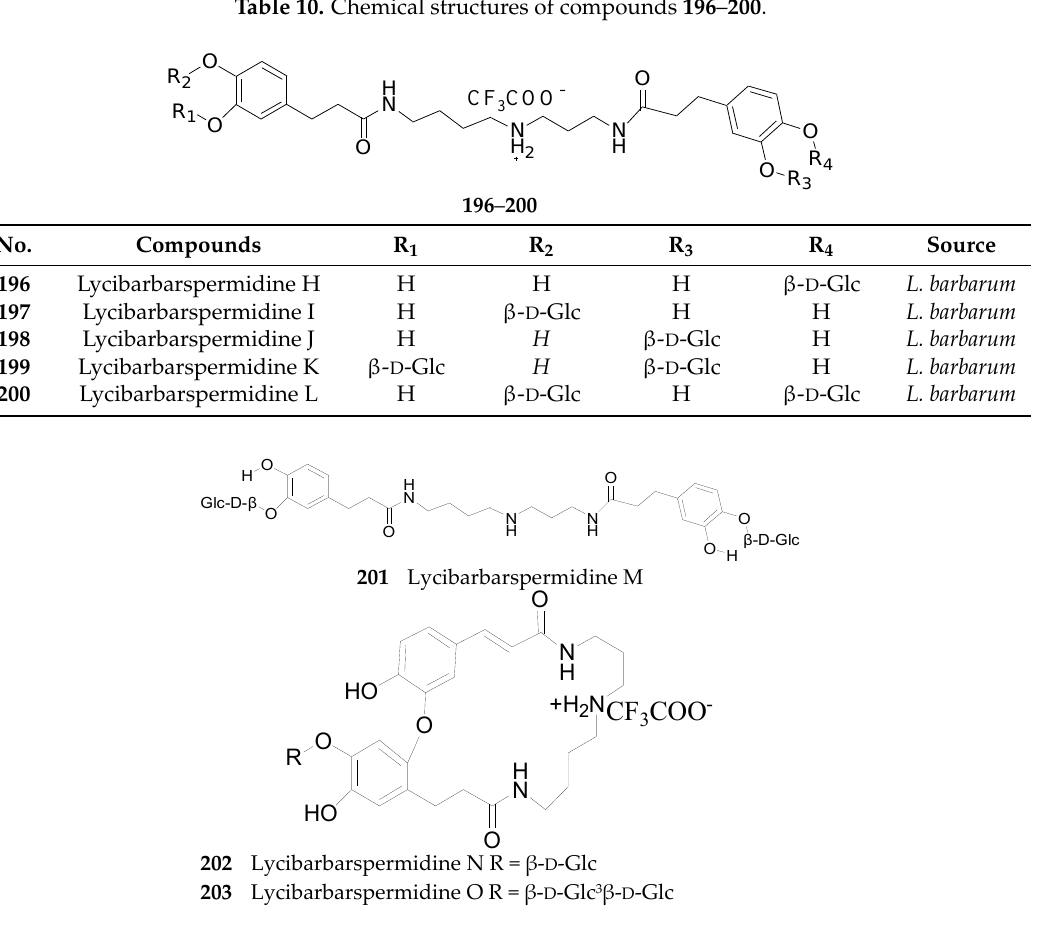
Figure 15. Chemical structures of compounds 201 – 203 .